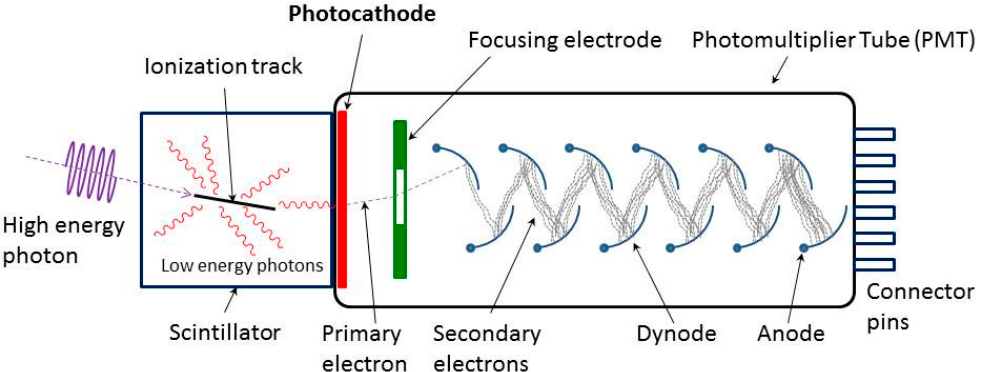
Figure 1. Working principle of a typical PMT [7]. A photon (ultraviolet, visible, or near-infrared light) is converted in the photocathode into a low-energetic electron, emitted into the vacuum. This electron is accelerated towards and focused onto the first dynode, releasing secondary electrons. This multiplication is repeated in subsequent dynodes, resulting in a measurable electric charge at the anode.